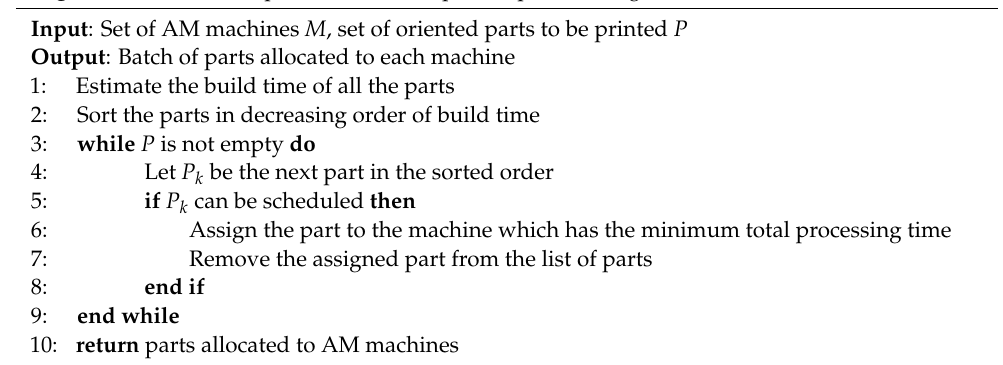
Algorithm 2: Heuristic procedure for the part-to-printer